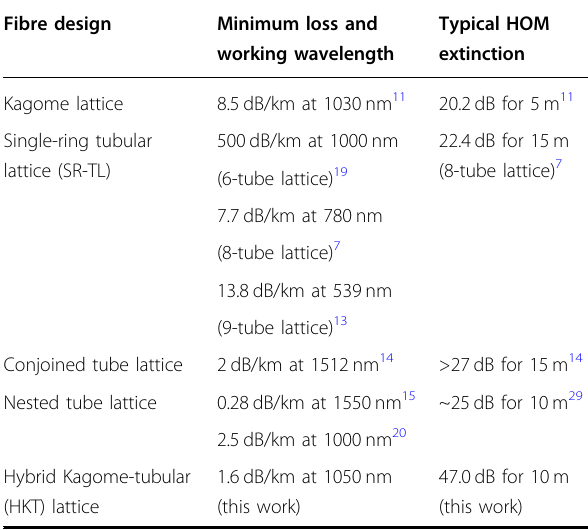
Table 1 Summary of the measured transmission loss fi gures and HOM (higher-order mode) extinction in representative